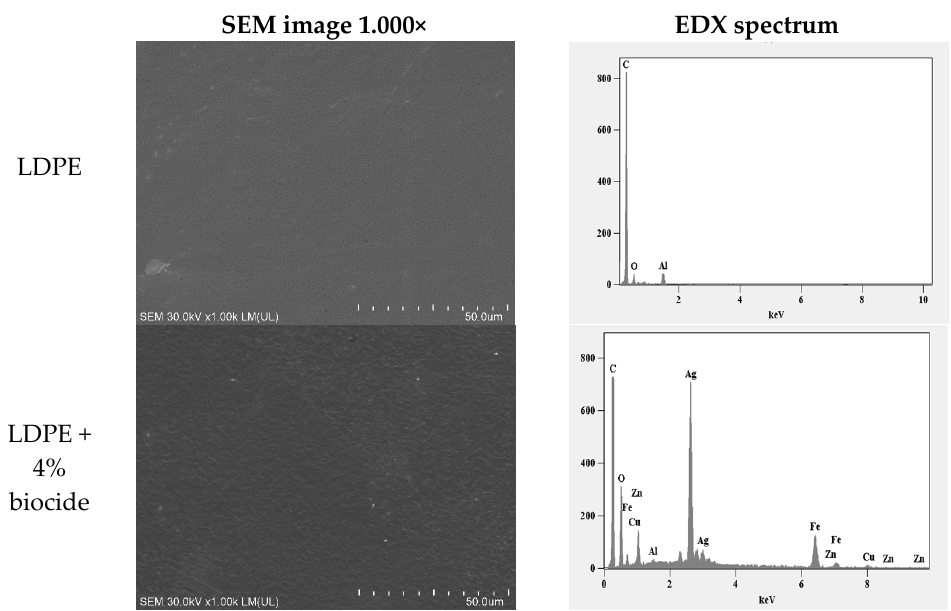
Figure 4. Scanning electron microscope (SEM) images showing the LDPE control and LDPE composite containing 4% biocide at 1000× magnification and their corresponding EDX spectra.